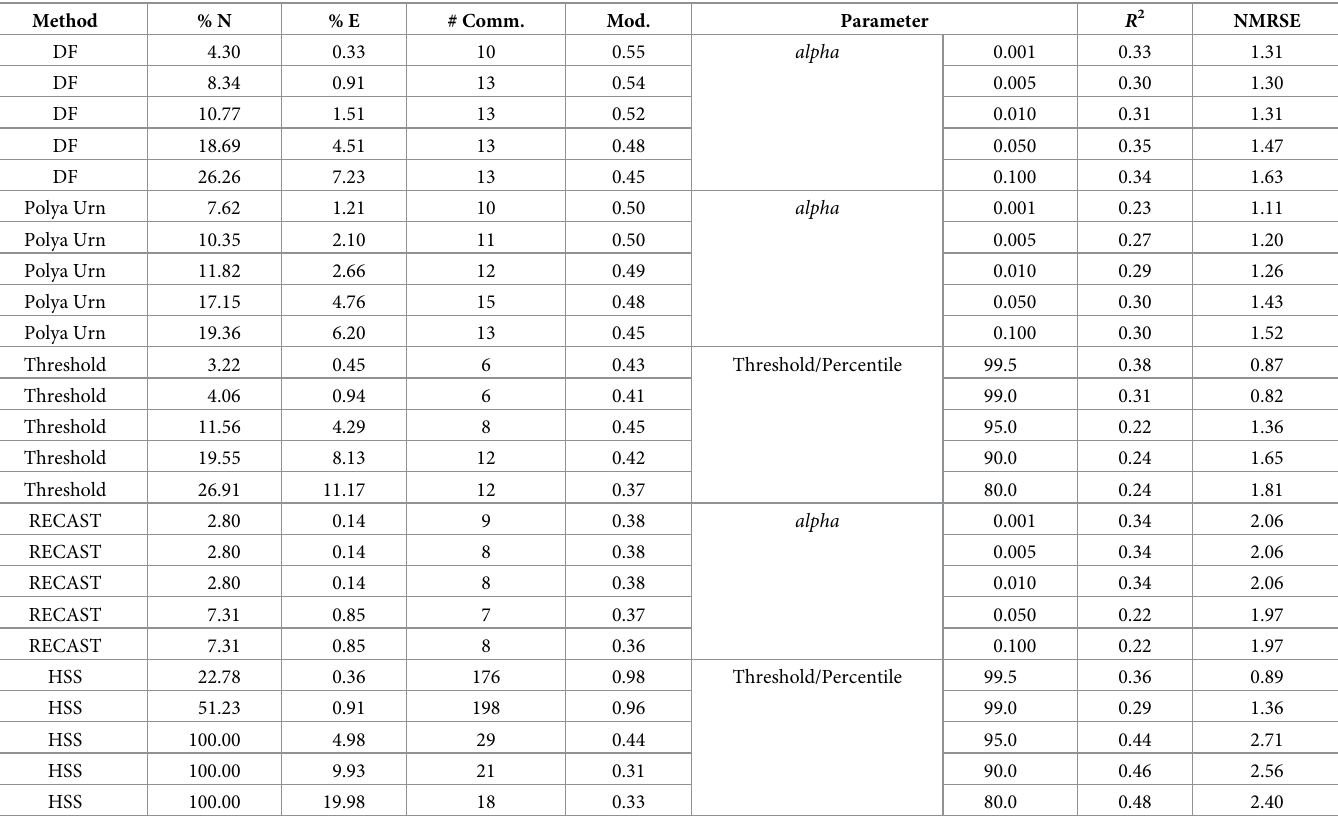
Table 7. Coordinated behavior on WhatsApp: Impact of method parameters on topological and contextual metrics.